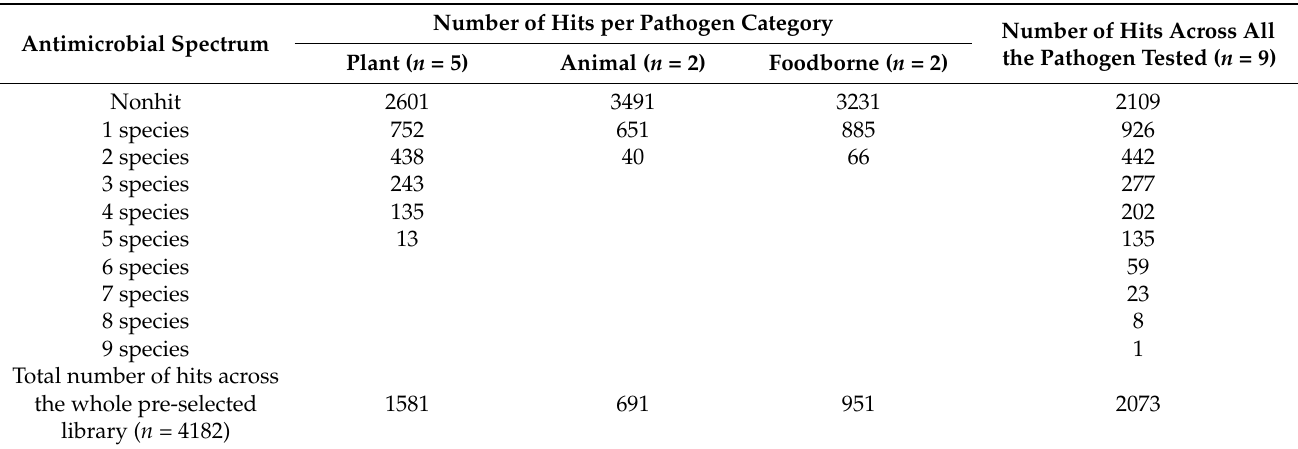
Table 2. Antimicrobial and spectrum of activity of the SM by pathogen categories. Antimicrobial